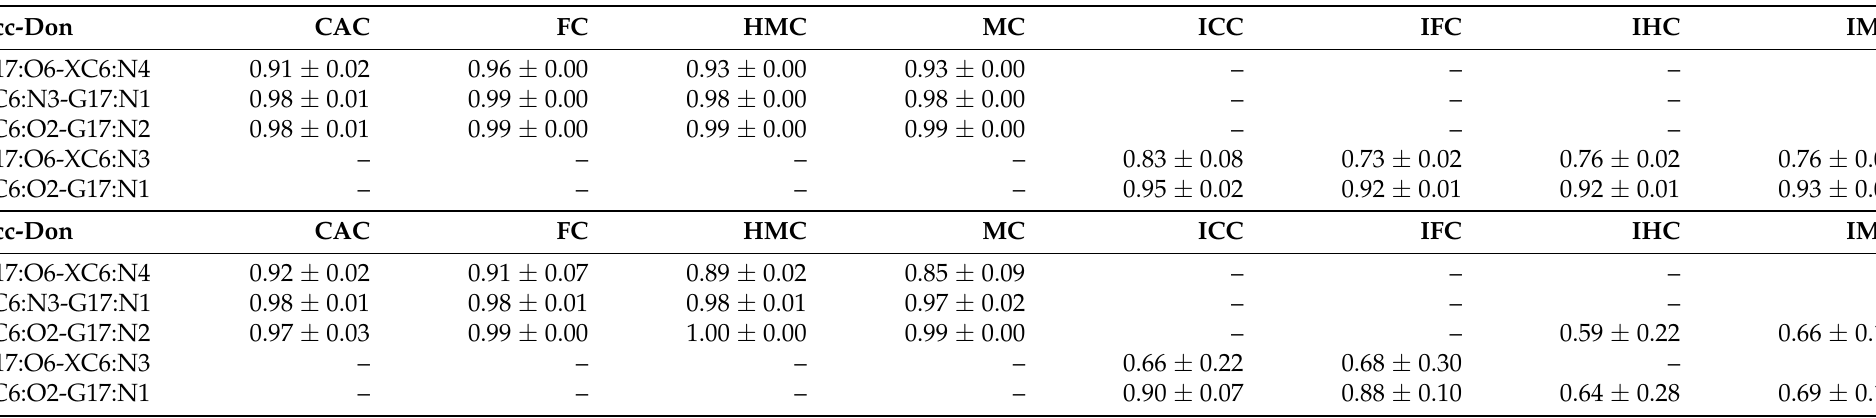
Table 1. Probabilities of hydrogen bonds between the oxidised methyl-cytosine (XC) and the complementary guanine (G) in (a) free DNA and (b) DNA complexed to TDG. For atom labels see Figure 2. Only hydrogen bonds that have a probability of at least 0.5 in at least one of the models are listed. For hydrogen bond probabilities between all other base pairs see Supplementary Figure